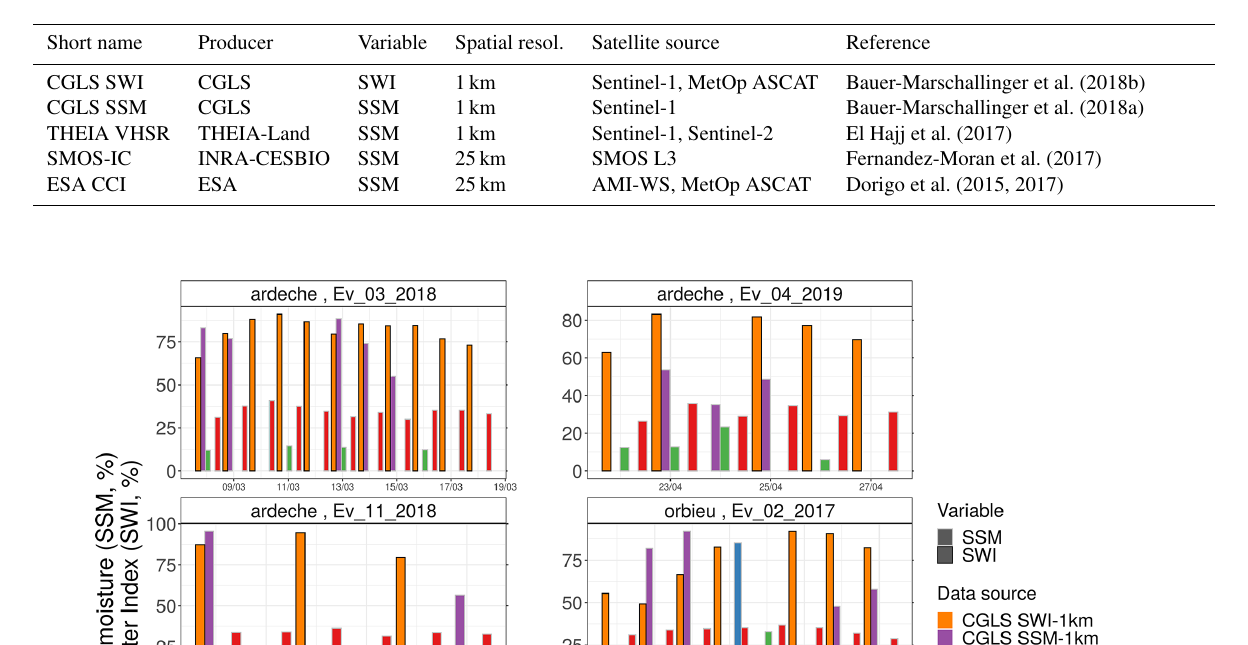
Table A1. Investigated satellite derived soil moisture products and their main characteristics. Shown are the data producer, Soil Water Index (SWI) or superficial soil moisture (SSM), spatial resolution, and the satellite imagery used.